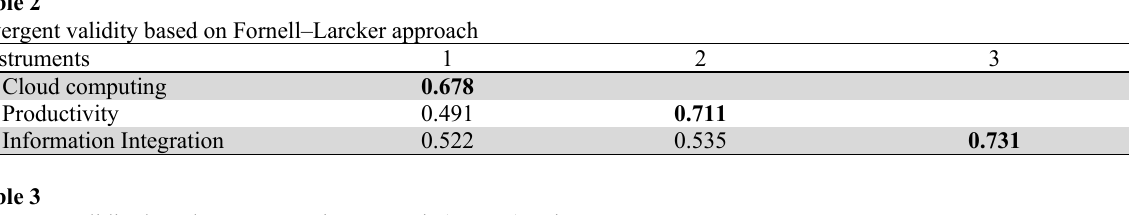
Divergent validity based on Heterotrait-monotrait (HTMT) ratio